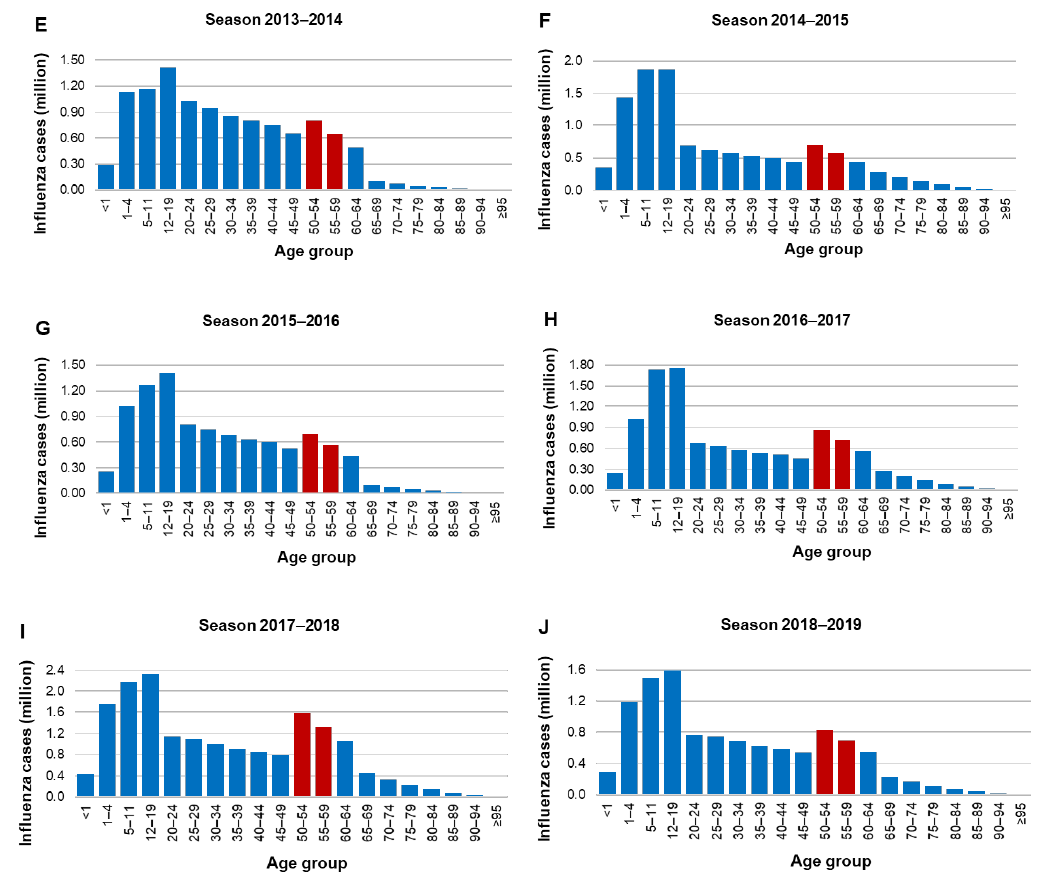
Figure 3. Estimated influenza cases by age group and season. ( A ) 2009–2010 season, ( B ) 2010–2011 season, ( C ) 2011–2012